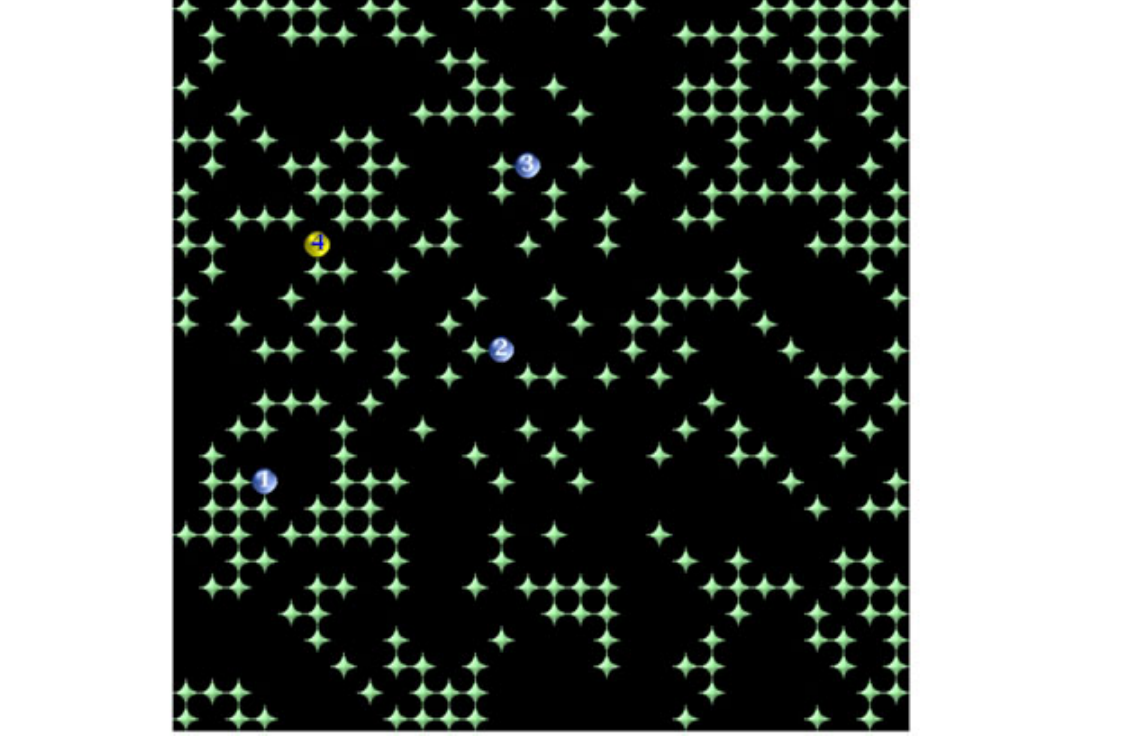
Fig. 1. Screenshot of the experimental environment. The green diamond-shaped tokens are the resource units. The dots are the avatars of the participants. The participant sees his/her own avatar colored yellow, and the avatars of others colored